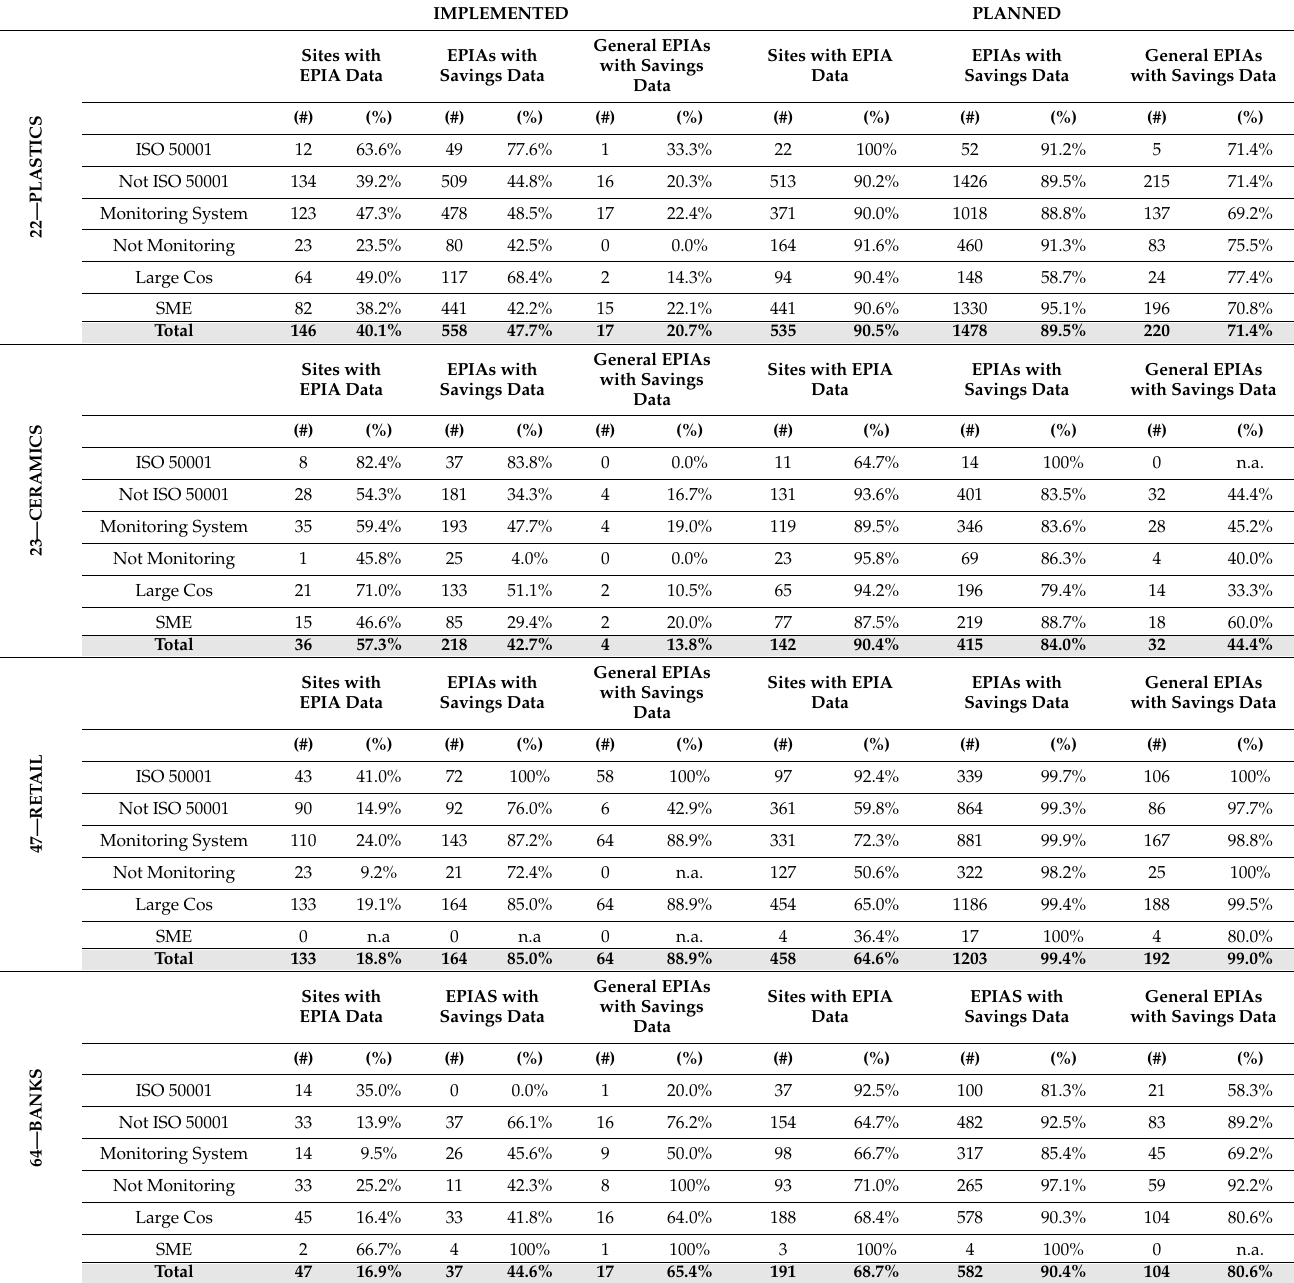
Table A2. Analysis of data available on energy audits: sites, EPIAs, and general EPIAs with information on savings. Implemented and planned EPIAs.